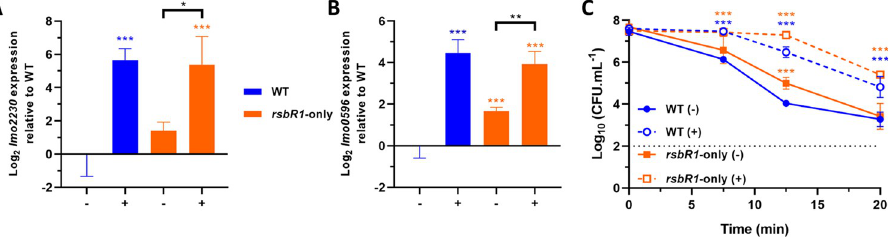
Fig 3. RsbR1 can act independently of its paralogues to transduce the low pH signals to activate σ B and enhance acid tolerance. Expression of σ B -dependent genes (A) lmo2230 and (B) lmo0596 , obtained from mid-log phase cultures of wild type and rsbR1 -only strains untreated (-) and treated (+) for 15 min in pH 5.0 at 37˚C. Gene expression is expressed as Log 2 relative gene expression. (C) Acid challenge of mid-log phase cultures treated in pH 5.0 for 15 min at 37˚C, as previously described in Fig 2D. Survival data is expressed as Log 10 (CFU.mL -1 ). The rsbR1 -only genotype consists on the following mutations, Δ rsbR2 ; Δ rsbR3 ; Δ rsbR4 ; rsbL (C56A). Statistical analysis was performed using a paired Student’s t -test relative to the wild type untreated after 15 min, for RT-qPCR data, and untreated wild type at time 0 min, for acid challenge data ( � , P value of < 0.05; �� , P value of < 0.01; ��� , P value of <